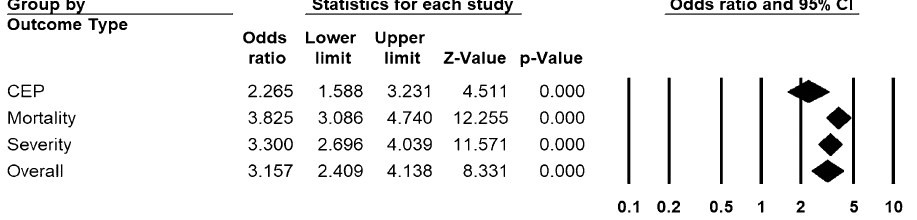
Figure 2. Pooled estimate of unadjusted odds ratios for the association of D-dimer with disease progression in patients with COVID-19.